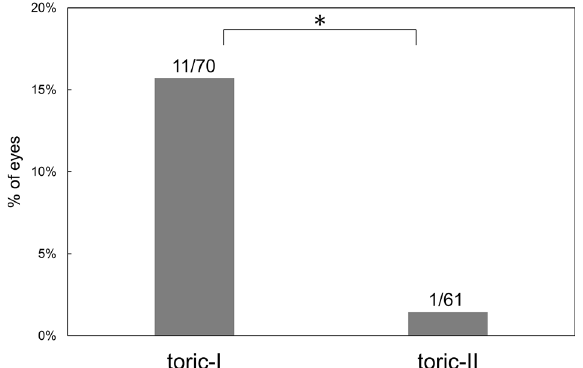
Figure 5. Percentage of eyes with misalignment > 10° was significantly smaller with toric-II than with toric-I IOLs (p = 0.0044).